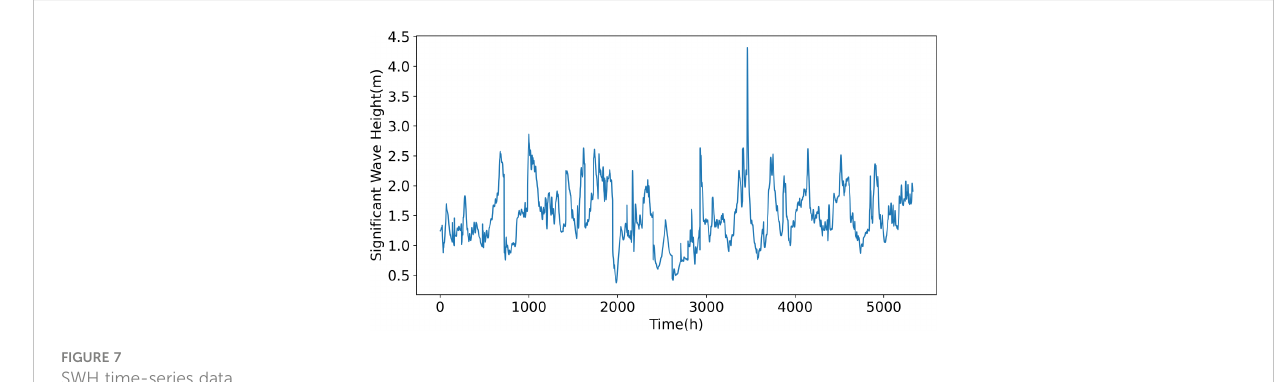
FIGURE 7 SWH time-series